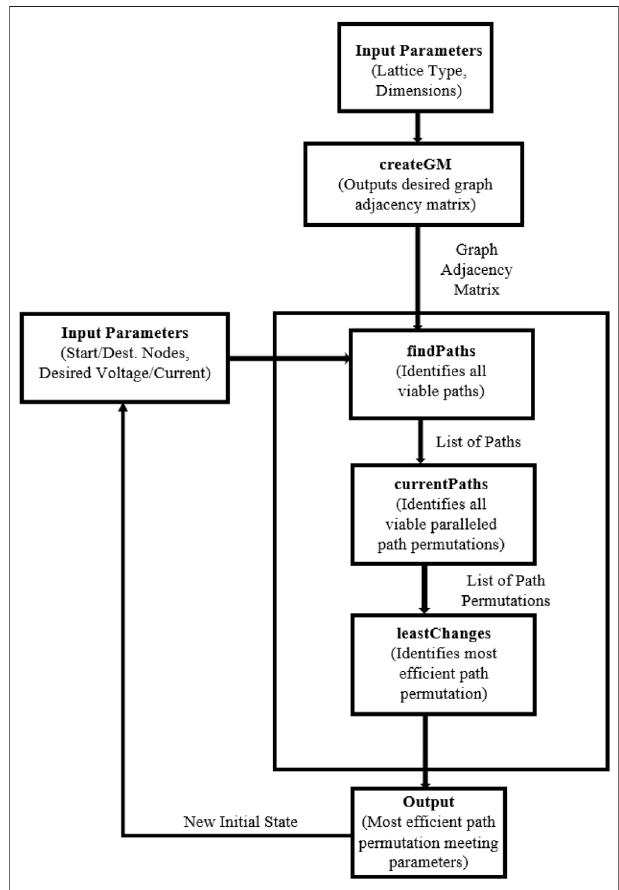
FIGURE 13 | Flowchart of